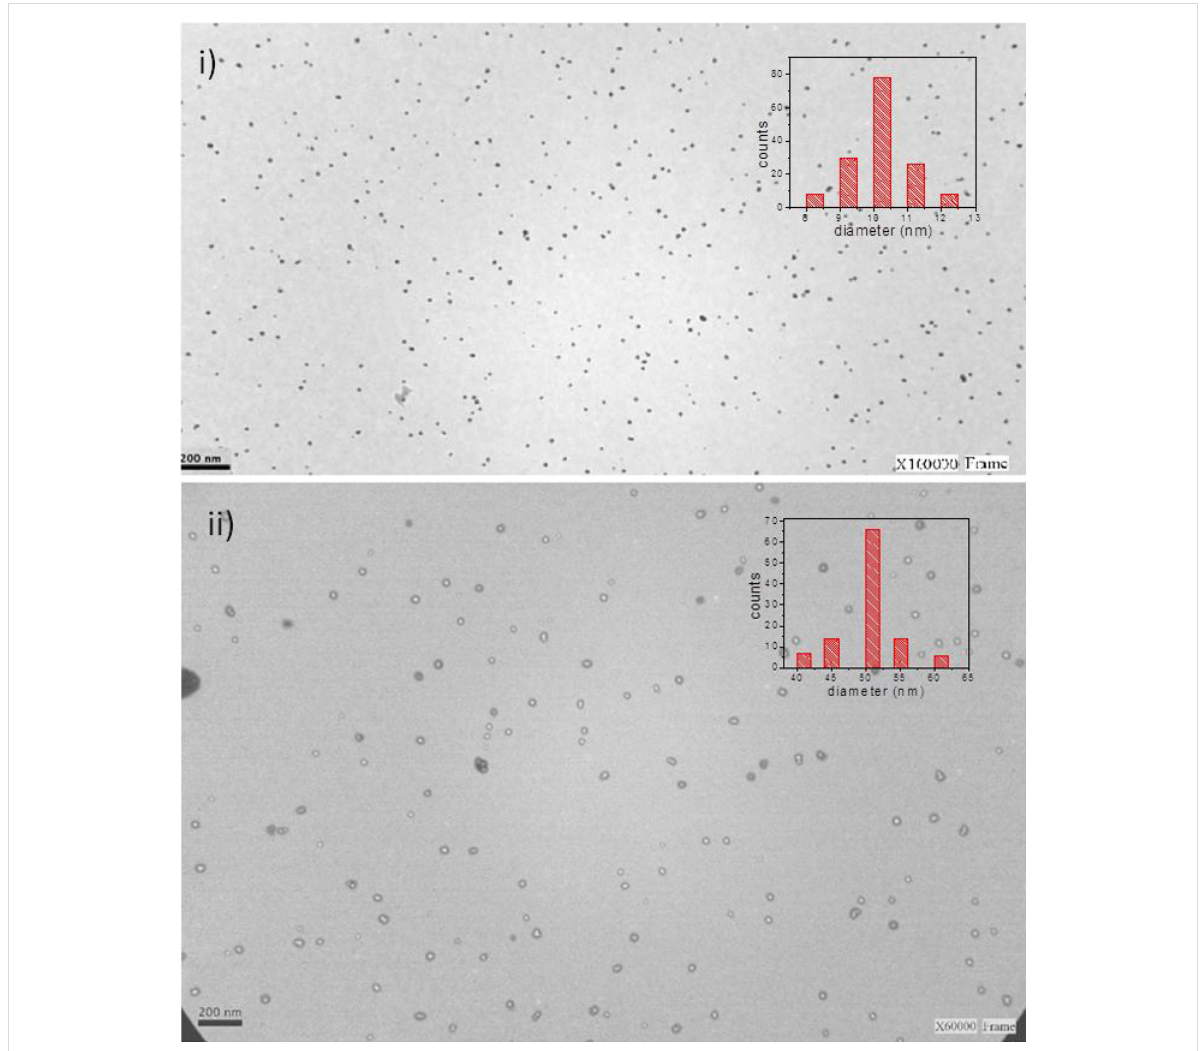
Figure 3: TEM images of AuNPs synthesized in glycerol by using ultraviolet irradiation for i) 8 min and ii) 13 min. The inset gives the histograms of di- ameters of the AuNPs based on the inspection of i) 150 particles and ii) 110 particles.